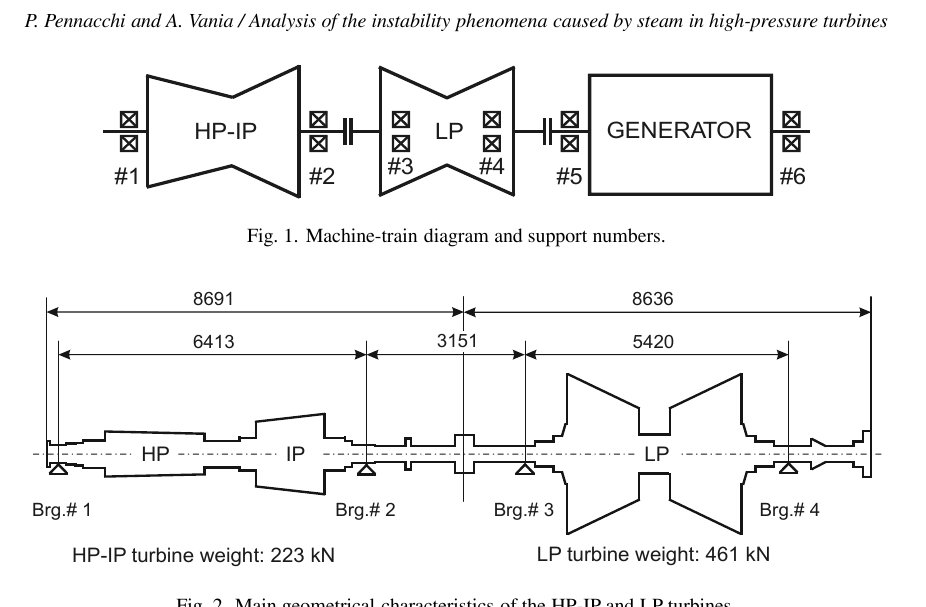
Fig. 2. Main geometrical characteristics of the HP-IP and LP